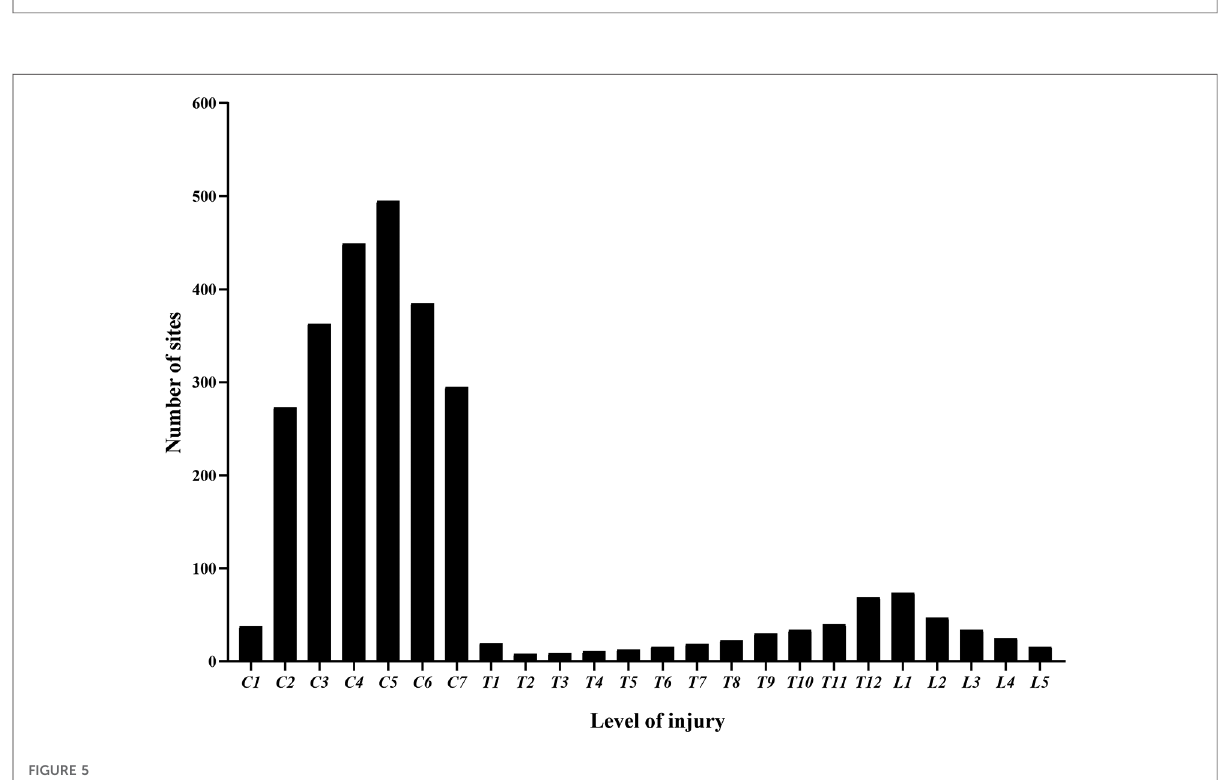
FIGURE 5 Distributions of sites of injury (C1 –